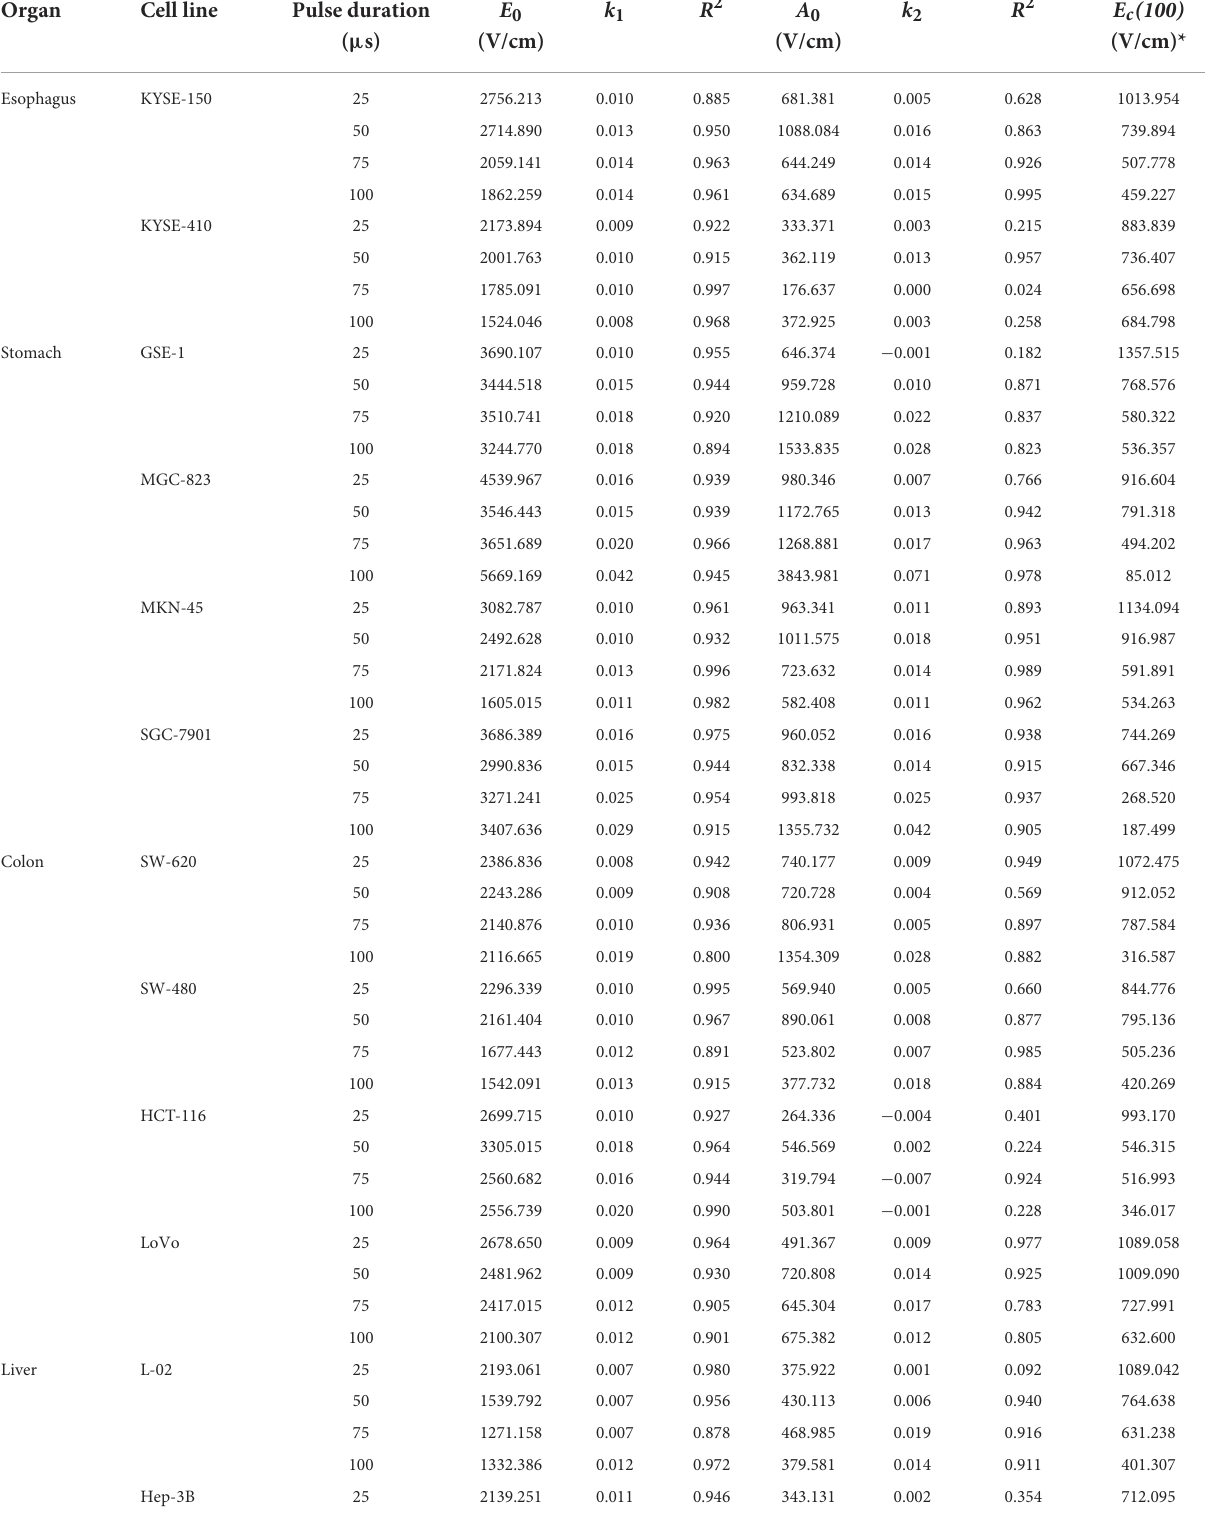
TABLE 3 The cell specific coefficients of the 20 digestive system cell lines under different pulse